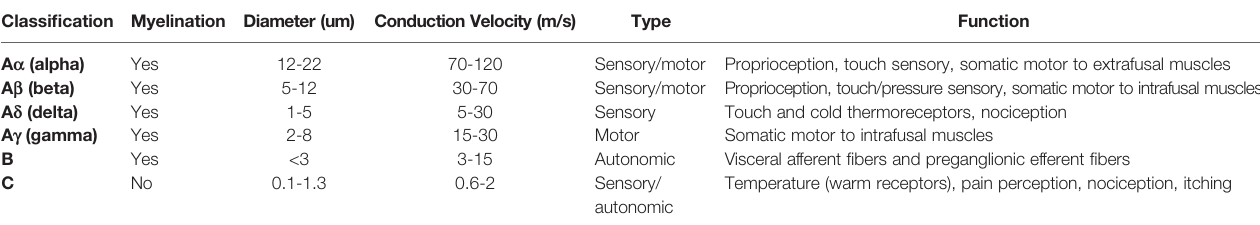
TABLE 1 | Classi fi cation of nerve fi bers in the peripheral nervous system according to modi fi ed Erlanger and Gasser. Classi fi cation Myelination Diameter (um) Conduction Velocity